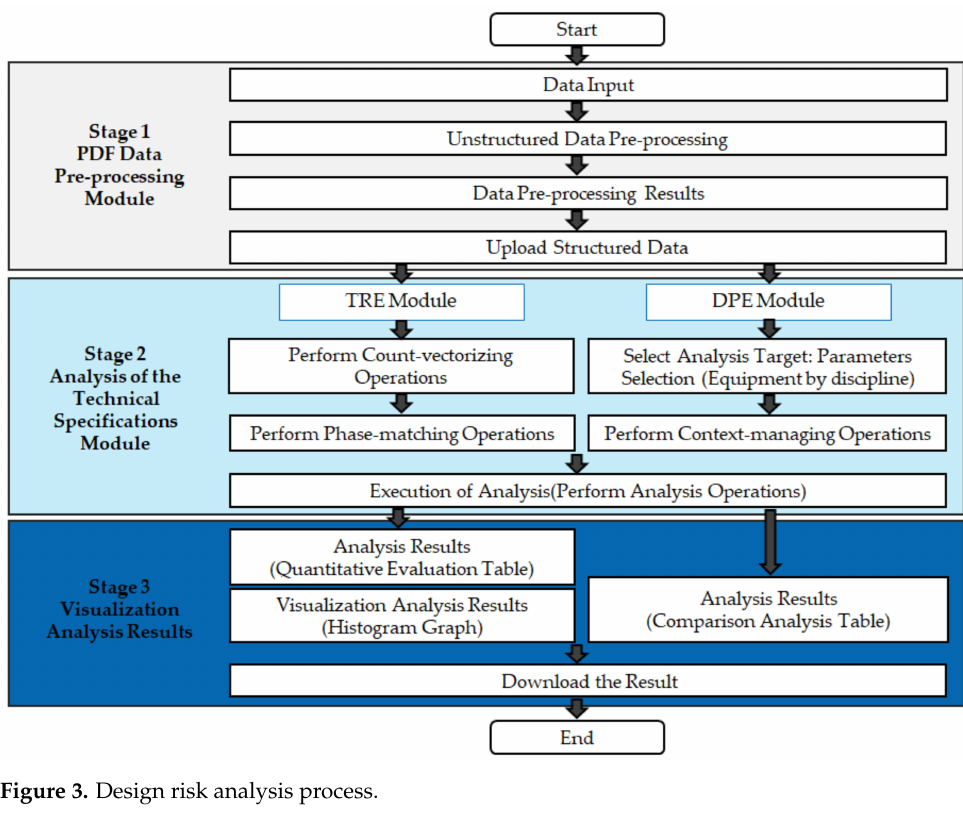
Figure 3. Design risk analysis process.